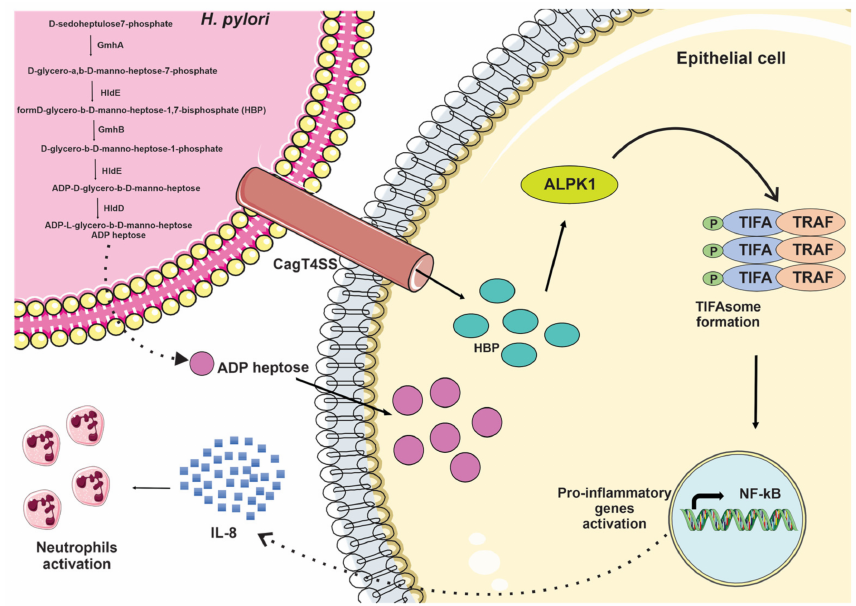
Figure 3. Schematic release and action of H. pylori heptose metabolites. HBP and ADP-heptose enter epithelial cells to induce TIFAsome formation and NF-kB